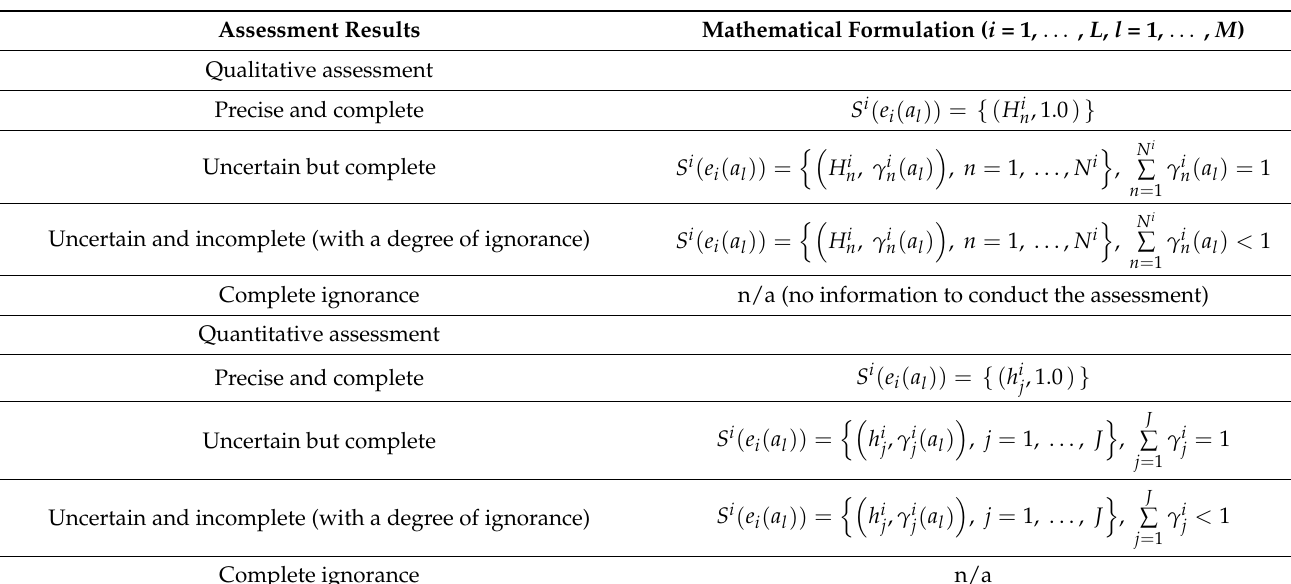
Table 4. Original forms of the assessment results